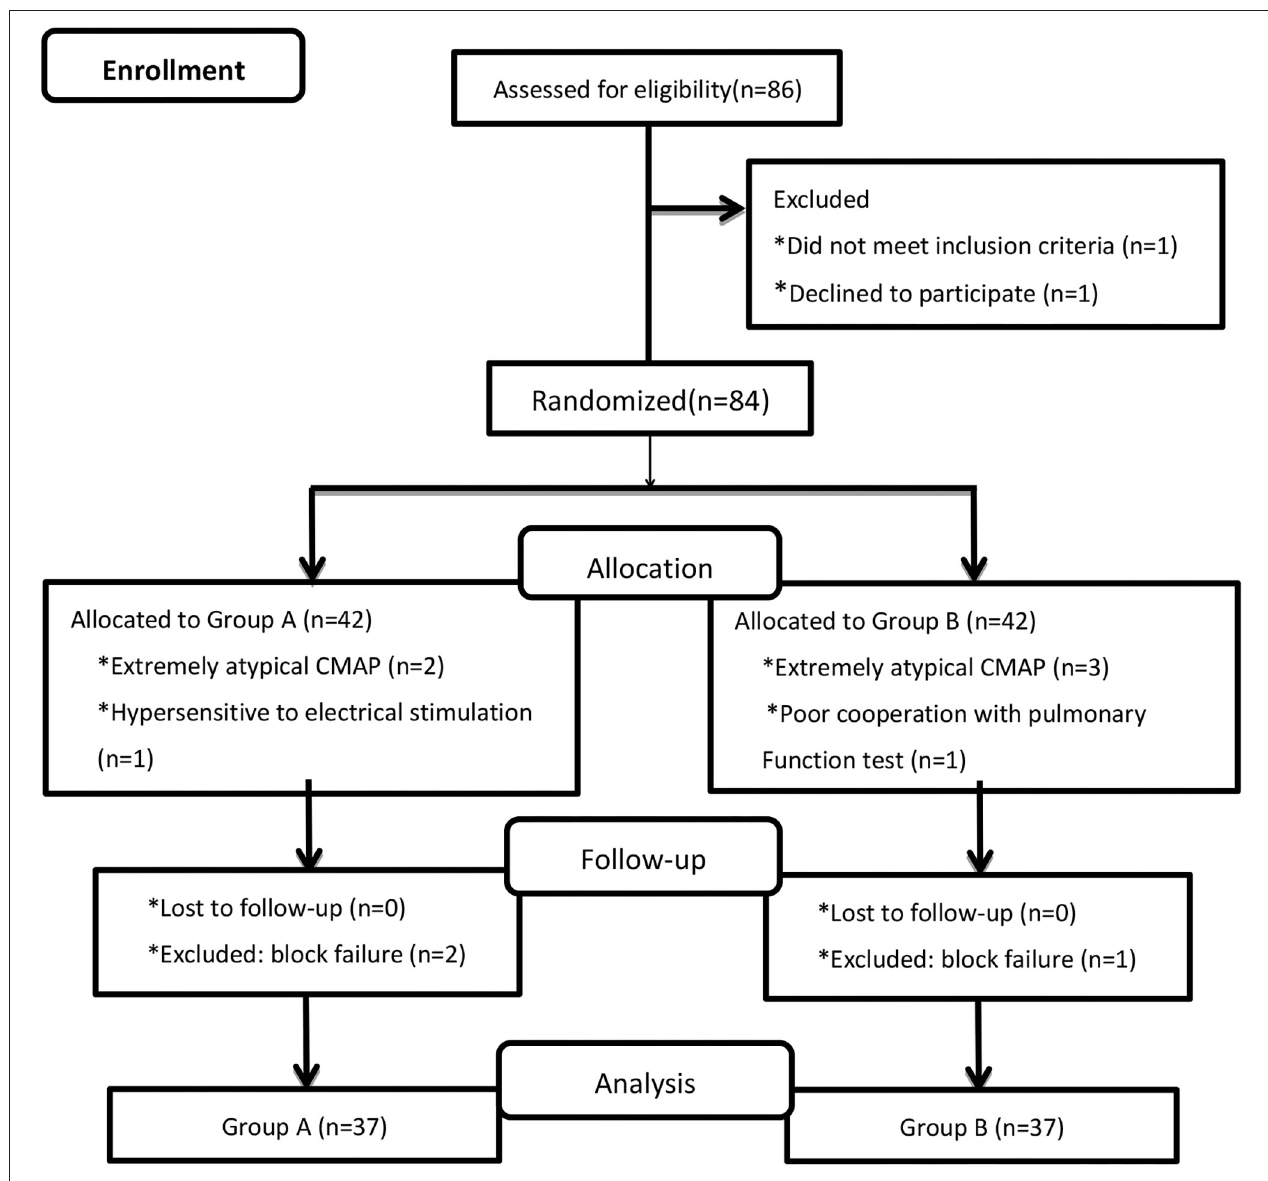
FIGURE 1 | Flowchart of patient selection. CMAP, compound muscle action